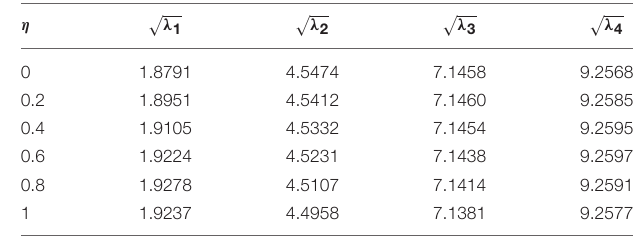
√ λ for CF case for different non-uniform (cid:16) (cid:17)